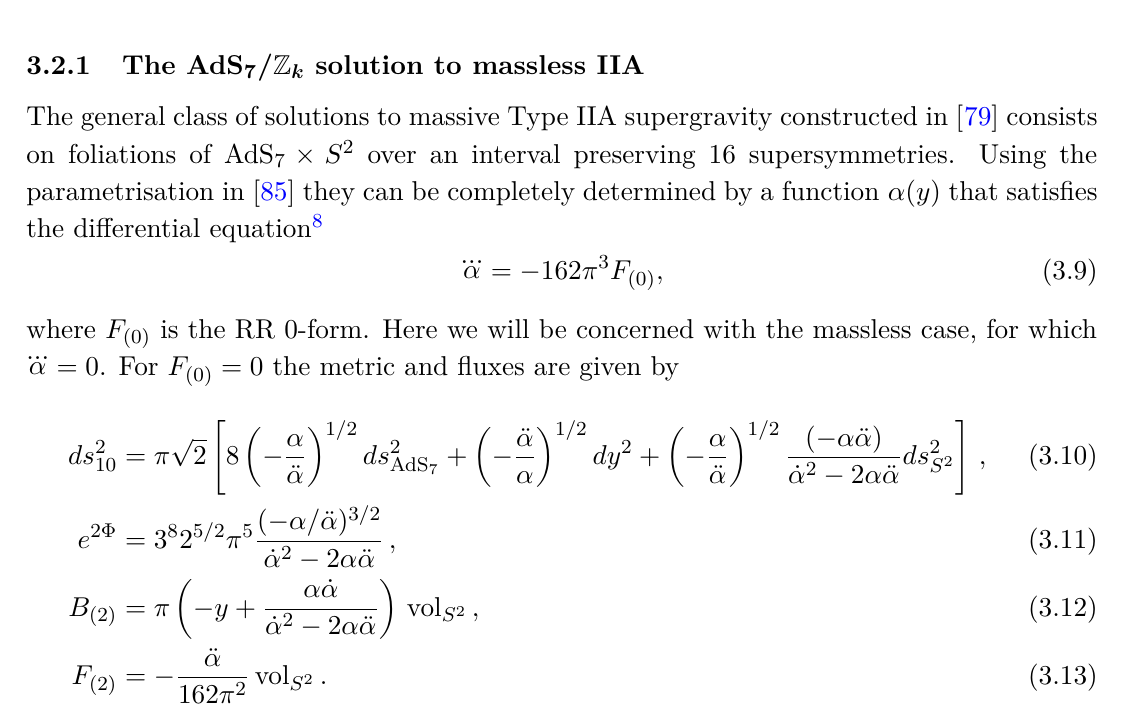
Table 3 . BPS/4 brane intersection underlying the massless AdS 7 solution to Type IIA. The 6d (1,0) dual CFT lives in the ( t, x 1 , x 2 , x 3 , x 4 , x 5 ) directions. y is the field theory